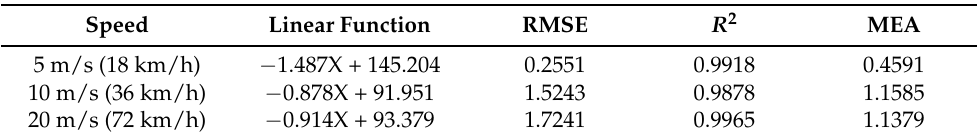
Table 4. The effect of a drone’s speed on the performance; the results are presented for location #1 and an altitude of 50 m, at various speeds.